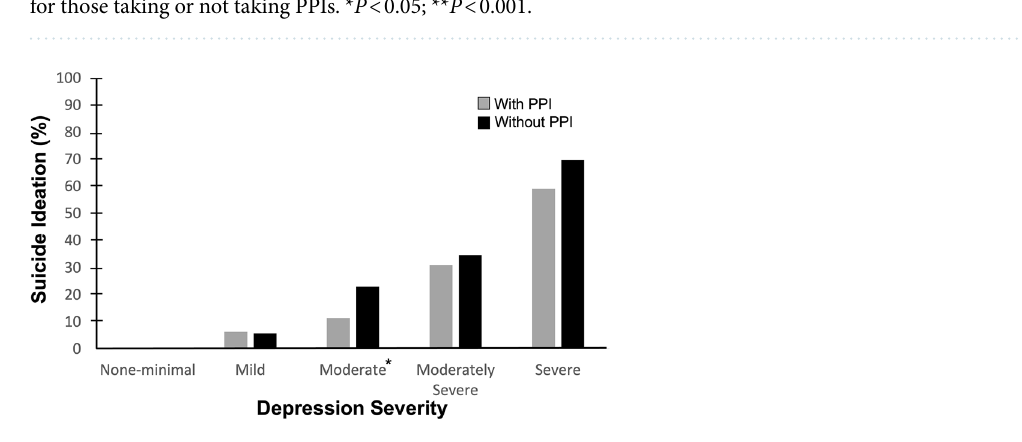
Figure 3. Weighted percentage of participants who had suicidal ideation by depression group for those taking or not taking PPIs. * P < 0.05. The suicidal ideation percentages of the none-minimal group for those taking or not taking PPIs were 0.27 and 0.33,